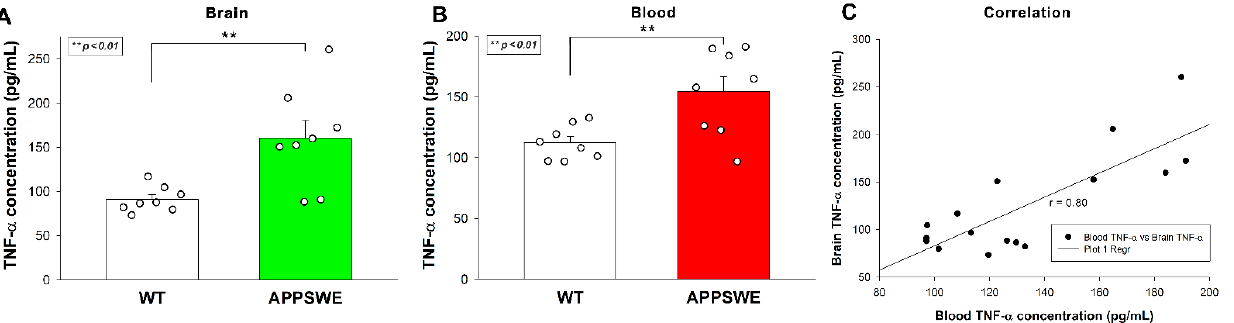
Figure 3. APPSWE-Tau mice exhibits increased TNF- α concentrations in the brain and the blood. ( A , B ) TNF- α concentrations of brain extracts ( A ) and whole blood ( B ) of APPSWE-Tau mice, along with representative WT controls, were measured with a mouse SDC3 ELISA kit. Each group contained 8 animals. The bars represent the mean + SEM. Statistical significance vs. WT was assessed with ANOVA. ** p < 0.01. ( C ) Linear regression between the TNF- α content of blood and brain.